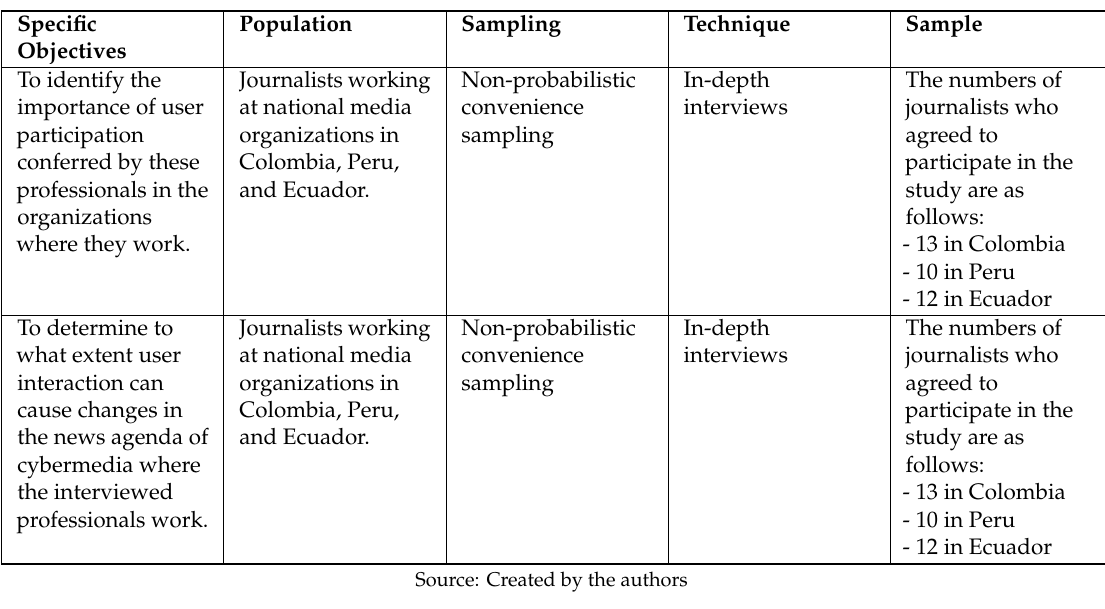
Table 1. Alignment of specific objectives, population, and sample design.